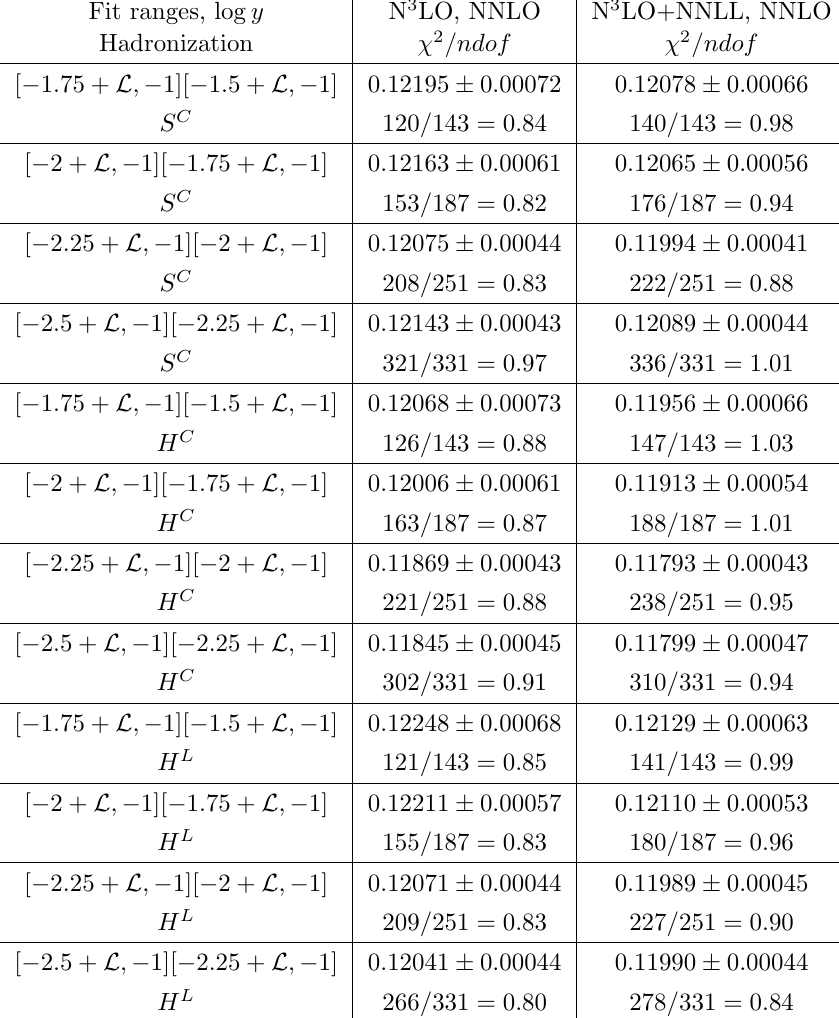
Table 4 . Simultaneous (cid:12)t of (cid:11) s ( M Z ) from experimental data for R 2 and R 3 obtained using N 3 LO and N 3 LO+NNLL predictions for R 2 and NNLO predictions for R 3 . Three di(cid:11)erent hadronization models are used and four di(cid:11)erent choices of the (cid:12)t range are shown, as given in the brackets, with L = log ( M 2 =Q 2 ). The (cid:12)t range for R 2 is given in the (cid:12)rst pair of brackets and the the (cid:12)t range 10 Z for R 3 in the second. The reported uncertainty is the (cid:12)t uncertainty only, as given by MINUIT2 .